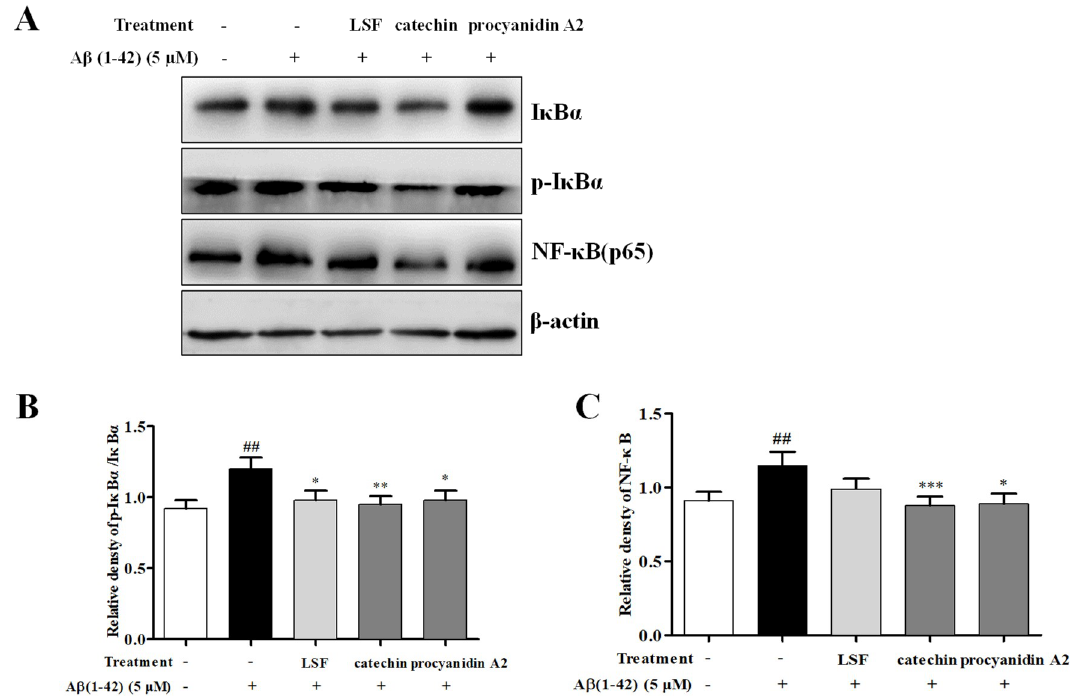
Figure 6. Catechin and procyanidin A2 inhibit the activation of the NF- κ B signaling pathway. BV-2 cells were pretreated with 5 µ M A β (1-42) for 12 h, followed by incubations of LSF (0.469 µ g/mL), catechin (10 µ M), and procyanidin A2 (10 µ M) for another 12 h. ( A ) After treatment, the cell lysates were harvested and subsequently employed for I κ B α , p-I κ B α , and NF- κ B detections using Western blotting. Band intensities of p-I κ B α /I κ B α ( B ) and NF- κ B ( C ) were quantified using Image J software and normalized to β -actin. Bars are representatives of three independent experiments. BV-2 cells treated with medium alone were set as the control group, and BV-2 cells treated with 5 µ M A β (1-42) alone were set as the A β group. ## p < 0.01 vs. control group; * p < 0.05, ** p < 0.01, *** p < 0.001 vs. A β group. The full-length Western blotting images are shown in Figure S8.